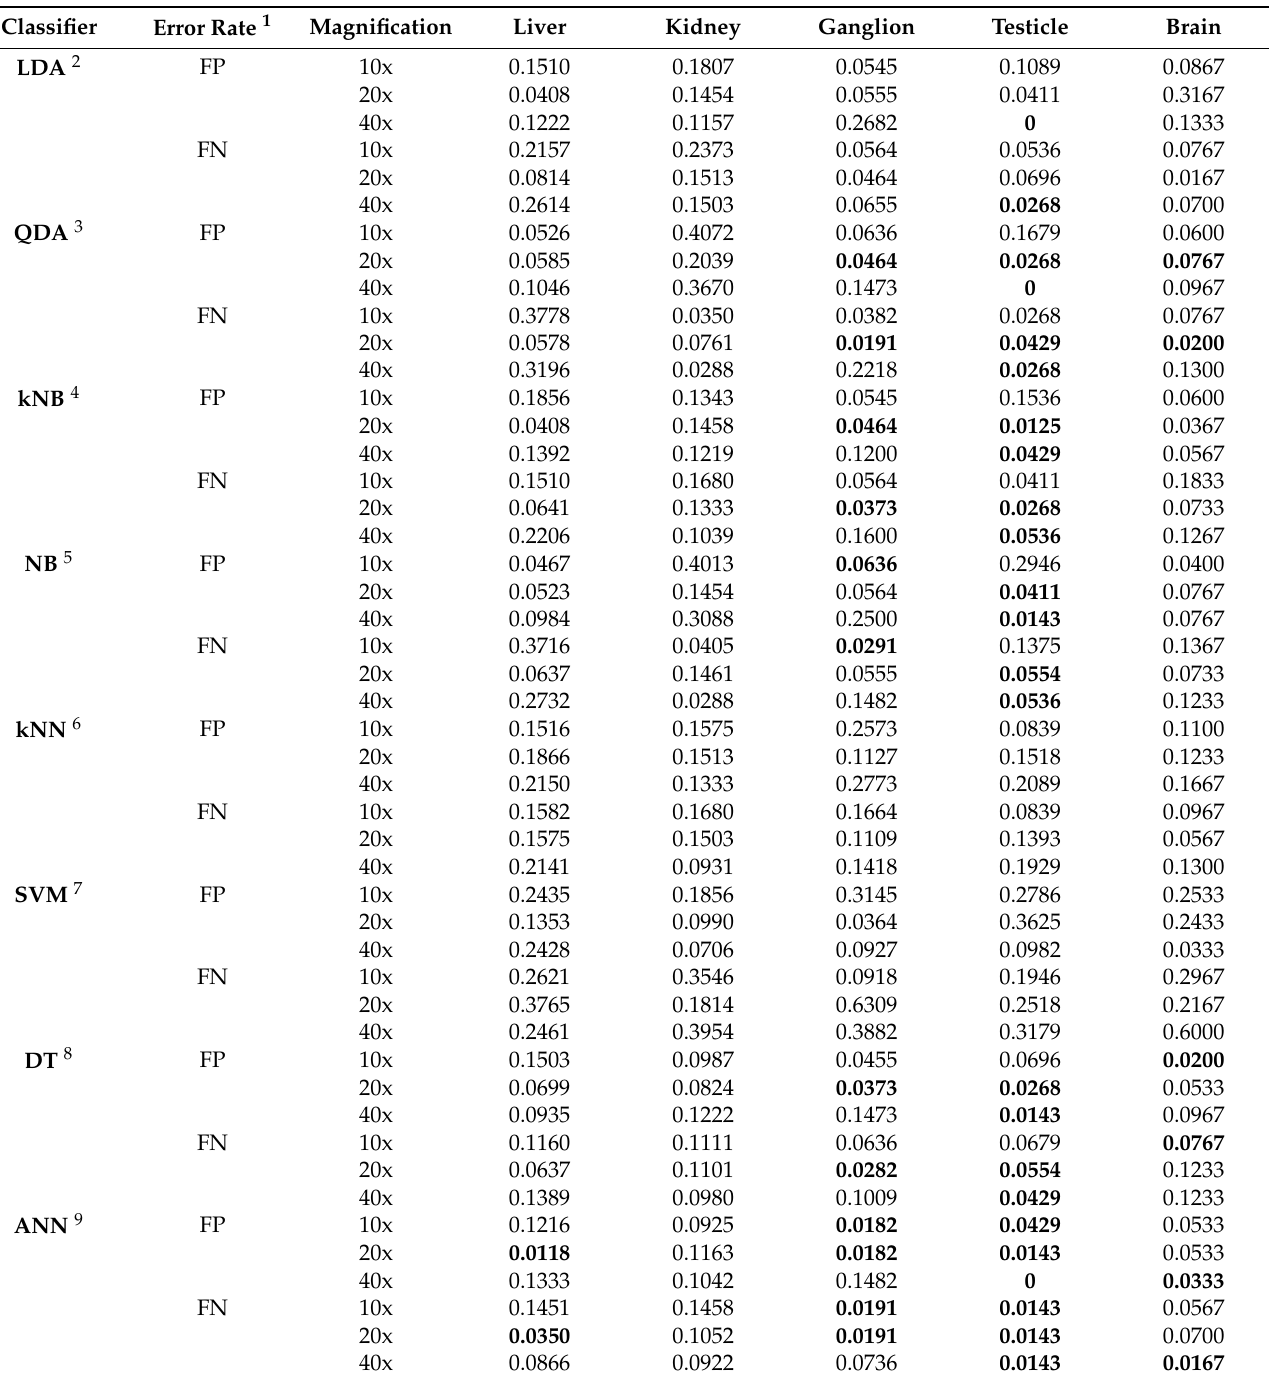
Table 4. Results of the cross-validation error, expressed separately for the false positive and false negative rates, for each tissue type and magnification. Combinations with total cross-validation error (FP + FN) < 0.1 are marked in